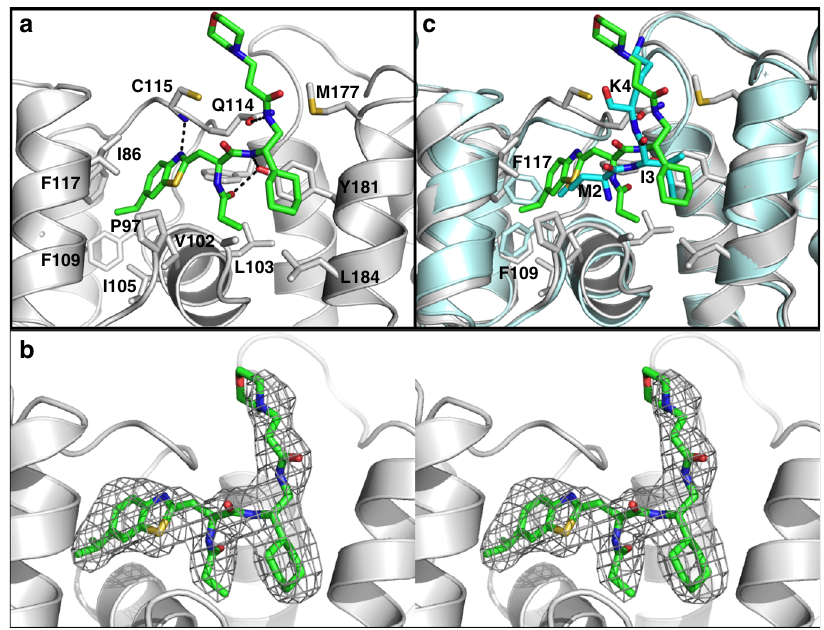
Fig. 3 Structural basis of the high-af fi nity binding of DI-591 to DCN1. a Co-crystal structure of DCN1 (gray) complexed with DI-591 (green). DCN1 residues interacting with DI-591 are shown as sticks with carbon atoms in gray, nitrogen atoms in blue, oxygen atoms in red and sulfur atoms in yellow. Hydrogen bonds are shown as dashed lines. b The stereo image of electron density map calculated prior to including DI-591 in the structural re fi nement is shown as a gray grid contoured at 3 σ . c Overlay of DCN1 (gray) – DI-591 (green) complex structure with DCN1 (light cyan) – UBC12 peptide complex structure (dark cyan) (PDB ID: 3TDU). Sidechains of residues F109 and F117 from the DCN1 – UBC12 structure are shown as cyan sticks. These residues change